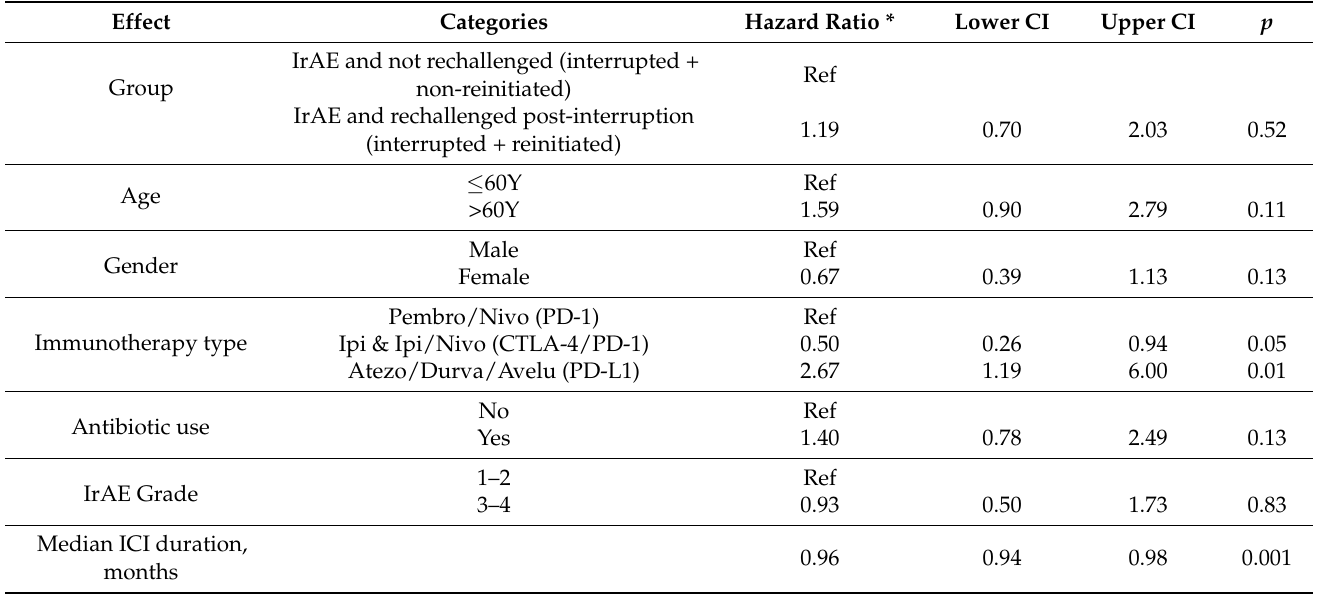
Table 5. Cox multivariate proportional model depicting the risk of overall survival in groups of ICI reinitiation status adjusting for the effect of covariates.